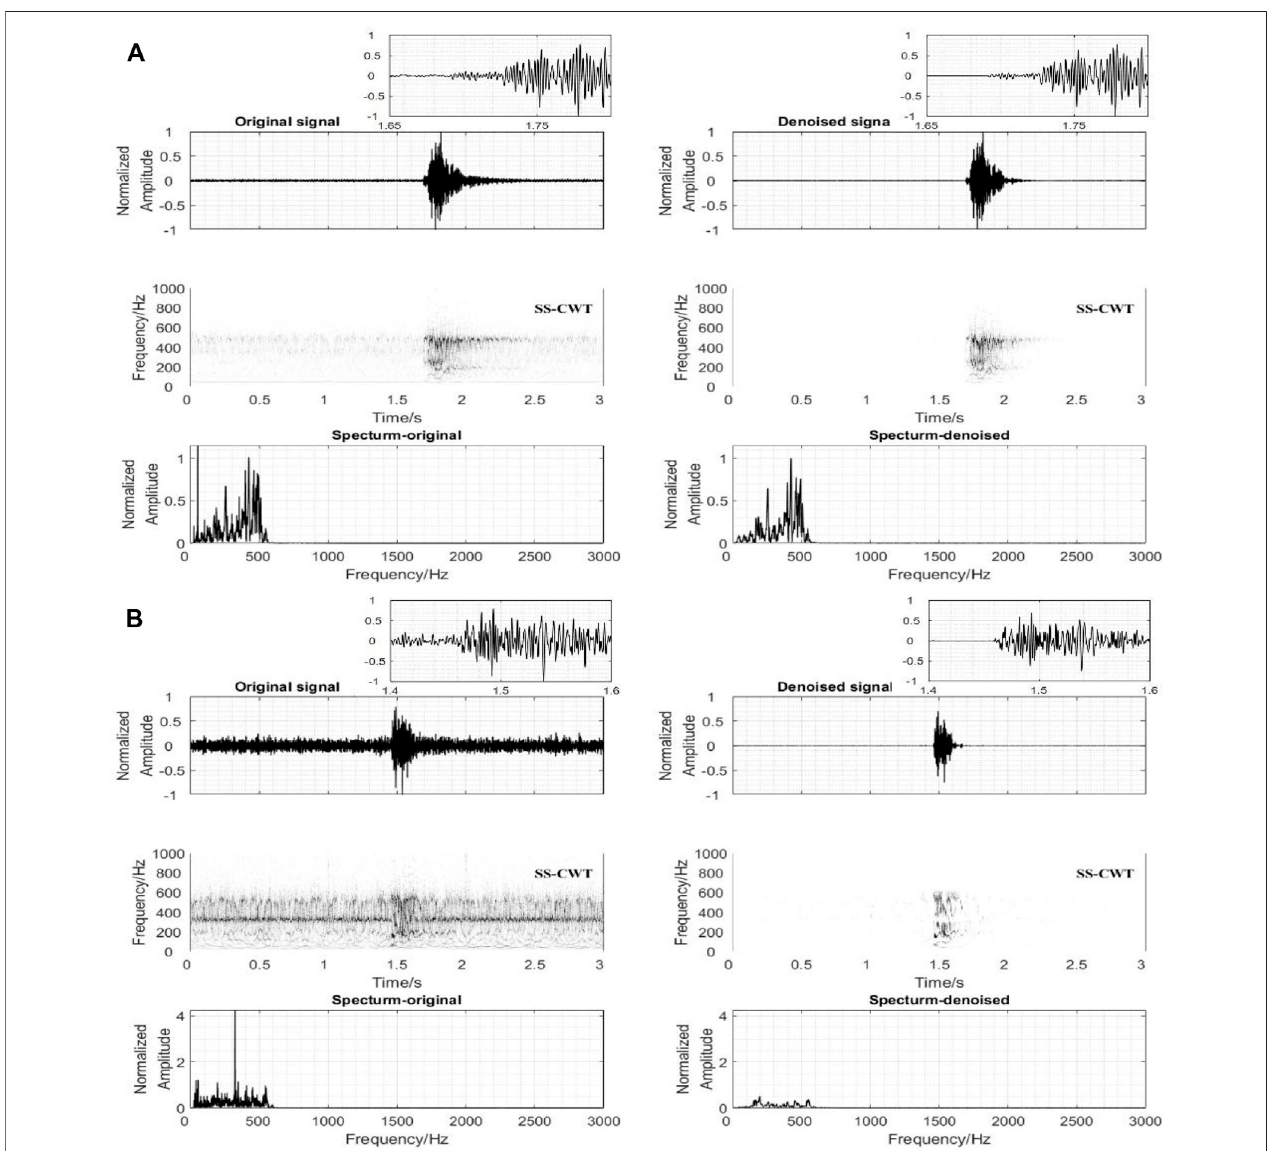
FIGURE 8 | Denoised results for mining-induced microseismic records of (A) high (B) moderate, and (C) low SNR using the proposed method.